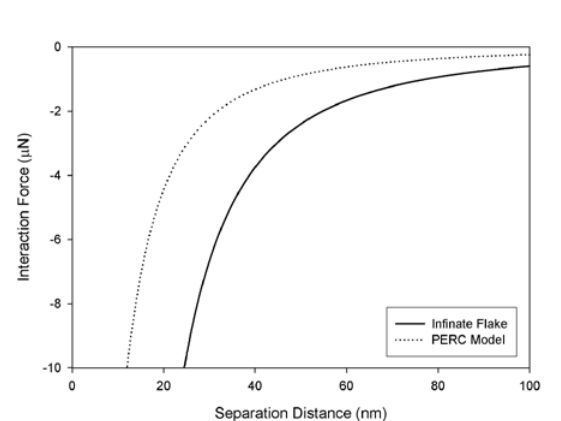
Calculated van der Waals forces of a smooth and rough surface. Surface roughness has a large effect on interparticle forces. Plot 1 (solid) shows the calculation of van der Waals attraction for two smooth surfaces. Plot 2 (dotted) shows the effect of surface roughness incorporated by the PERC model 53, 54) which not only decreases the contact area, but also separates the average sur- face plane of each body. A significant decrease in the calculated interaction force is